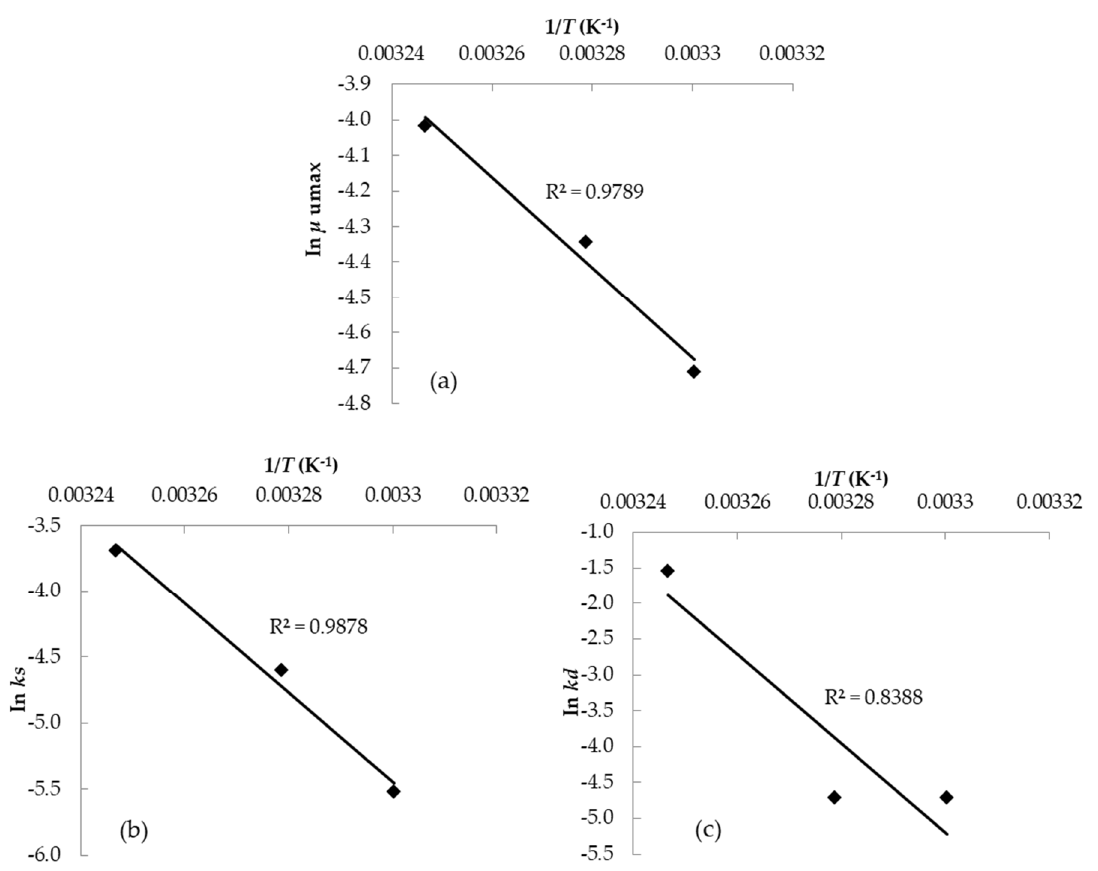
Figure 4. Arrhenius plot for SSF to determine μ max ( a ), ks ( b ) and kd ( c ).